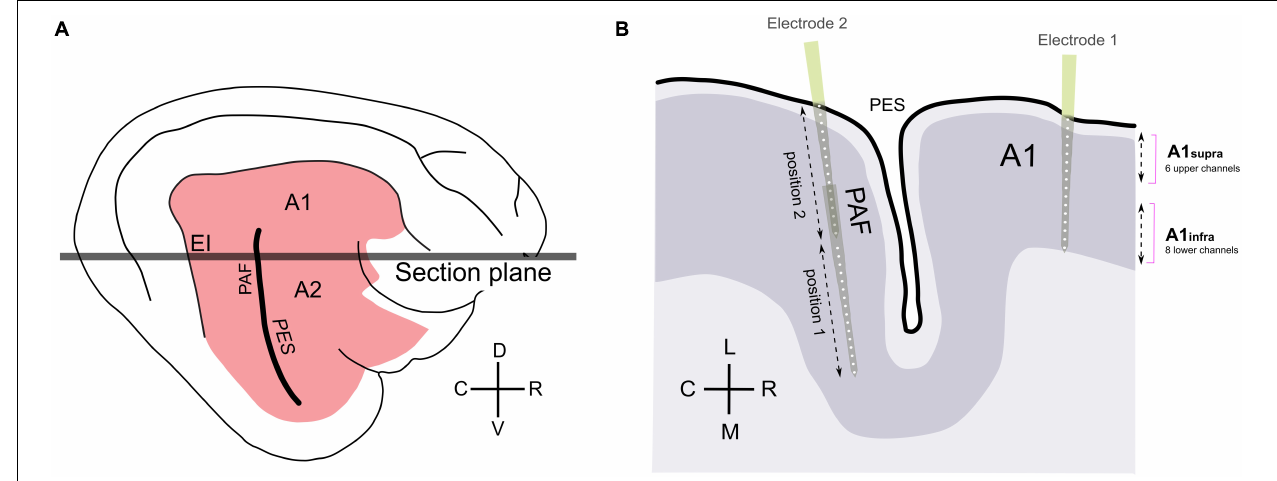
FIGURE 1 | Schematics of recording positions. (A) Schematics of feline auditory cortex; the present experiments were performed in areas A1 and PAF. (B) Schematic illustration of the sectional plane of the auditory cortex from panel (A) , showing electrode penetrations in A1 and PAF. Based on histology, 6 upper channels in field A1 were grouped together (supragranular channels), and 8 lower channels in A1 were grouped together (infragranular channels). In PAF, penetrations down to 5,000 µ m in two steps were used to densely map this field; each penetration included 32 recording sites in total. A1, primary auditory cortex; EI, intermediate area of the posterior ectosylvian gyrus; PAF, posterior auditory field; PES, posterior ectosylvian sulcus; D, dorsal; V, ventral; C, caudal; R, rostral; L, lateral; M,